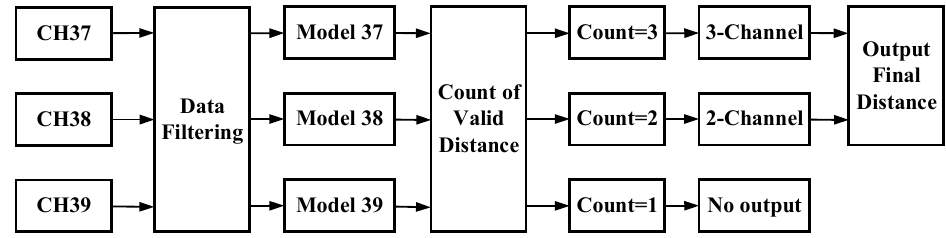
Figure 3. Overview of the proposed algorithm for outputting the final distance.